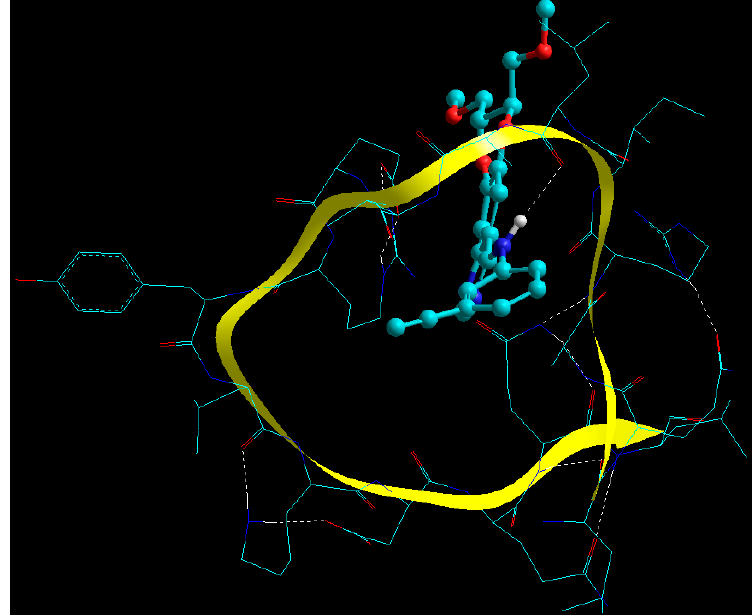
Figure 5. Visualization of geometrical preferences and functional interactions between BSA (stick rendering) in complexation with the ERL molecule (ball-and-tube rendering) after molecular mechanics simulations in vacuum. Colour codes: C (cyan), O (red), N (blue) and H